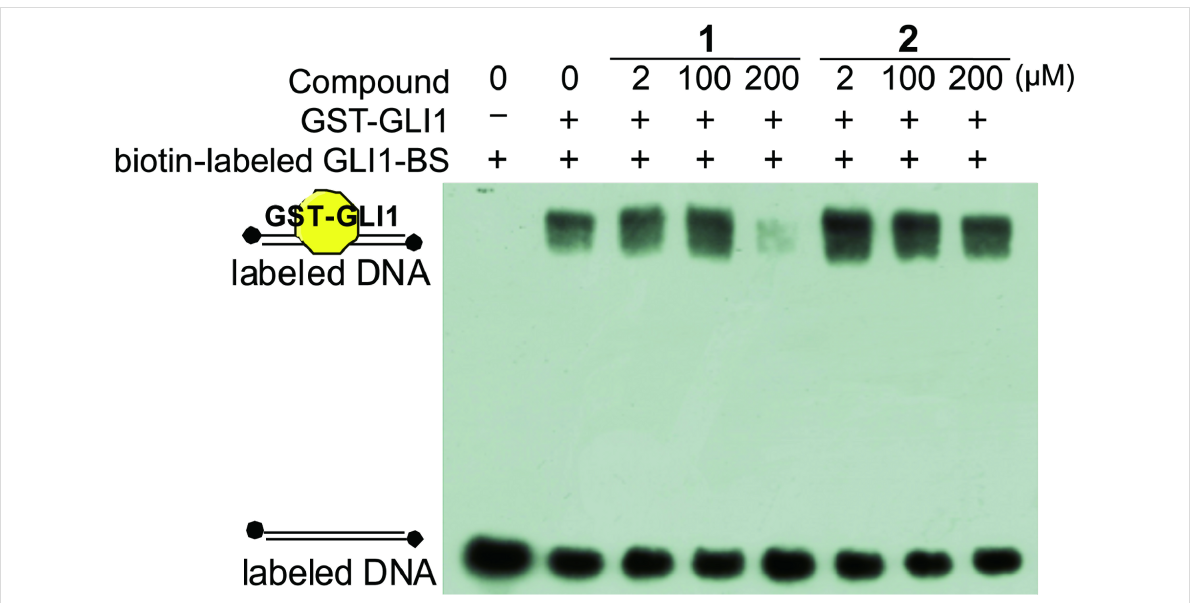
Figure 5: Inhibitory activity of GLI1–DNA-complex formation by electron mobility shift assay (EMSA). GST–GLI1 (171-515aa), DNA containing the GLI1 binding site (GLI1–BS); 5’-AGCTACCTGGGTGGTCTCTTCGA-3’. The reproducibility was checked in five individual experiments.